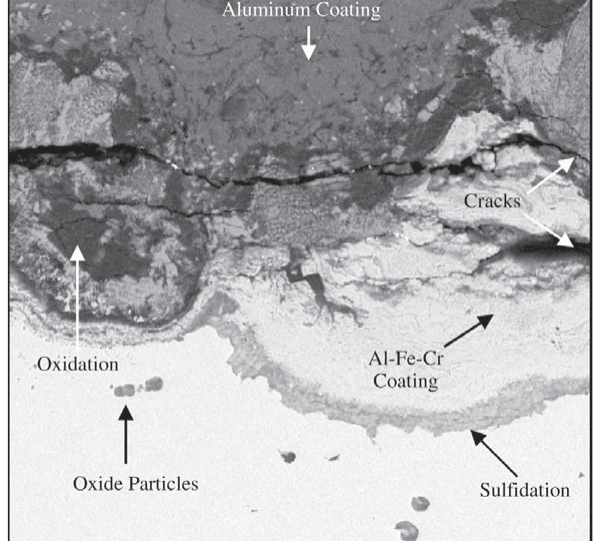
Figure 4. Cross-section of aluminum coated steel corroded at ver- tical furnace for 200h at a higher